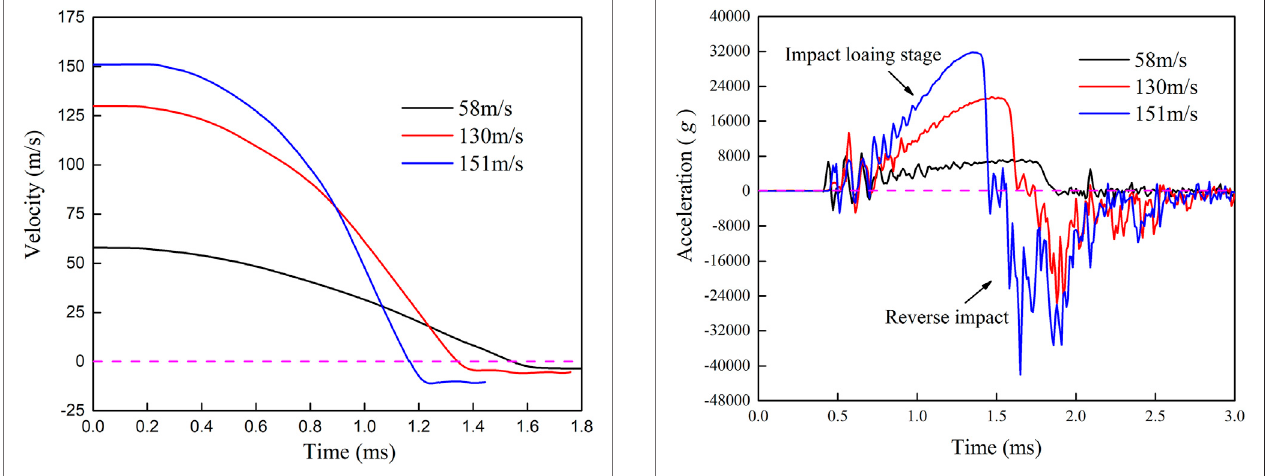
FIGURE 13 | Acceleration signal characteristics of the missile-borne recorder.